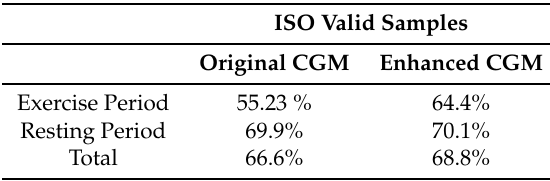
Table 7. Table of the results for the classification of the CGM samples within the bounds as defined in ISO 15197: